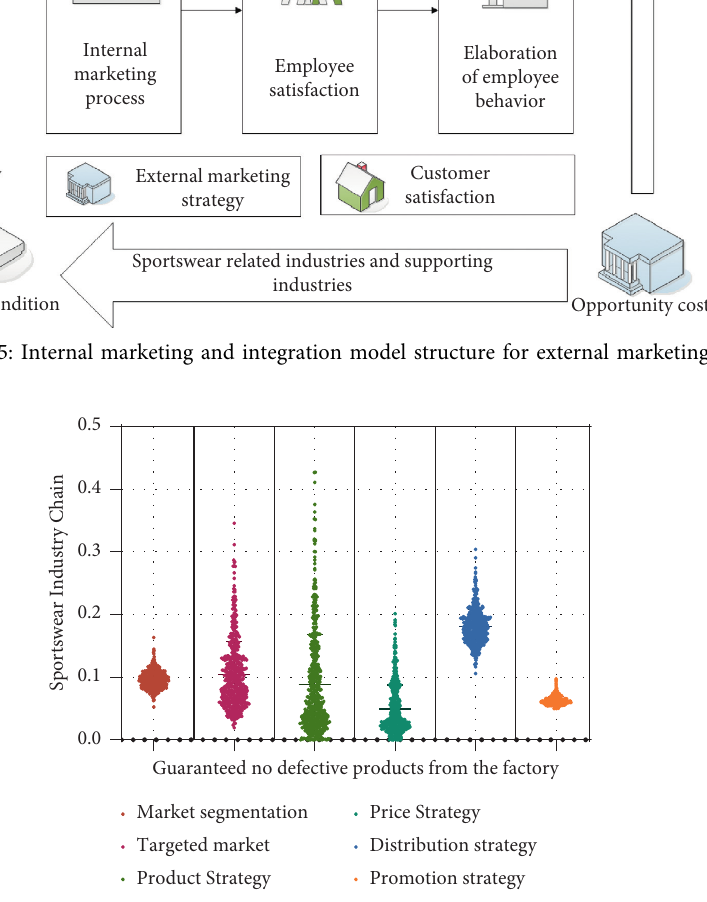
Figure 6: The results of market comparison scores by behavioral